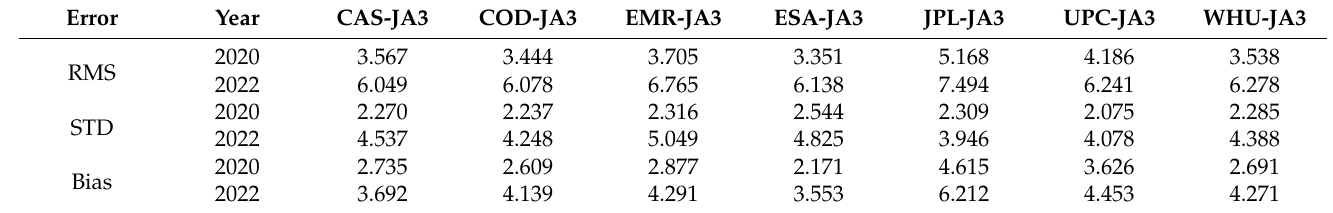
According to the graphs, it can be found that the STD and bias between Jason-3 altimeter satellites and different GIMs in 2020 are overall less than those in 2022. The results show that the systematic VTEC deviations are more than 1 TECu between each GIM of different agencies and the Jason-3 altimeter satellite, which is consistent with the fact that the altimeter satellite observations do not include the ionospheric TEC from the altimeter satellite orbit altitude to the GNSS satellite orbit altitude. The differences are significantly larger in the middle years of solar activity compared to the low years, for which the mean bias and STD values are 4.373 TECu and 3.046 TECu compared to 4.439